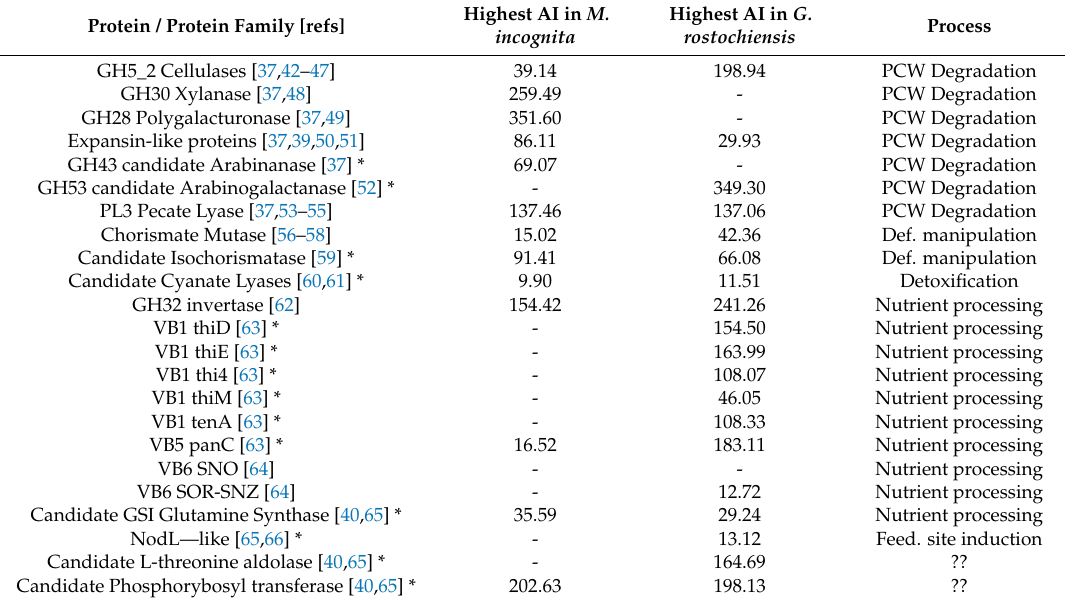
Table 1. Horizontal gene transfer (HGT) cases supported by manual phylogenetic analysis in root-knot and cyst